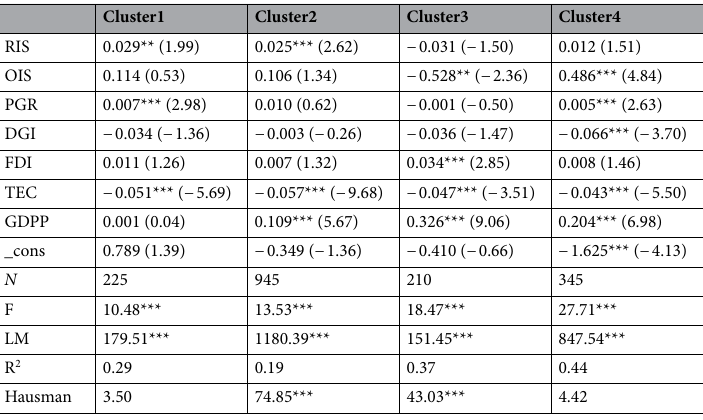
Table 5. Grouped regression results. * p < 0.1, ** p < 0.05, *** p < 0.01; the bracket represents the t